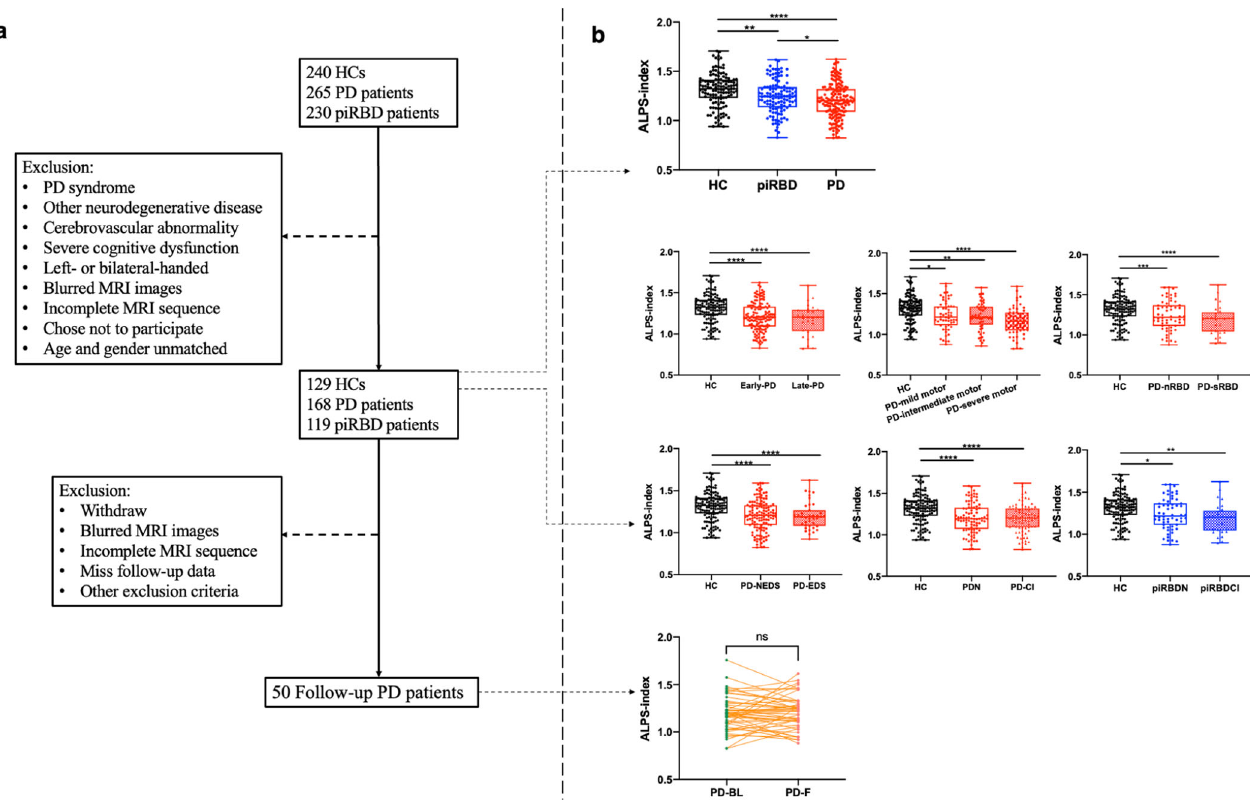
Fig. 1 Subject screening work fl ow and quantitative analysis of the ALPS index. a The subject screening work fl ow. b Data are presented as box plots, with the box representing the median and the two middle quartiles (25 – 75%). Whiskers are the maxima and minima. Different pattern of ALPS index among three groups (PD < piRBD < HC, P < 0.001). Post hoc test revealed a higher ALPS index in the HC group than in the piRBD ( P = 0.001) and PD groups ( P < 0.001), and a higher ALPS index in the piRBD group than in the PD group ( P = 0.036). Subgroup analysis of PD or piRBD patients revealed no signi fi cant difference ( P > 0.05). Longitudinal ALPS index between PD-BL and PD-F revealed no signi fi cant difference (p >